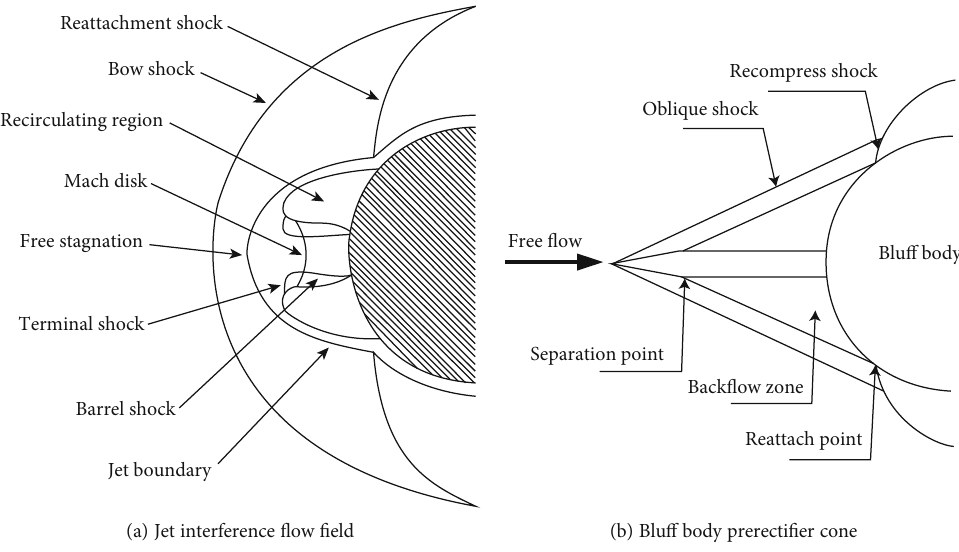
Figure 1: Schematic diagram of the drag reduction technology